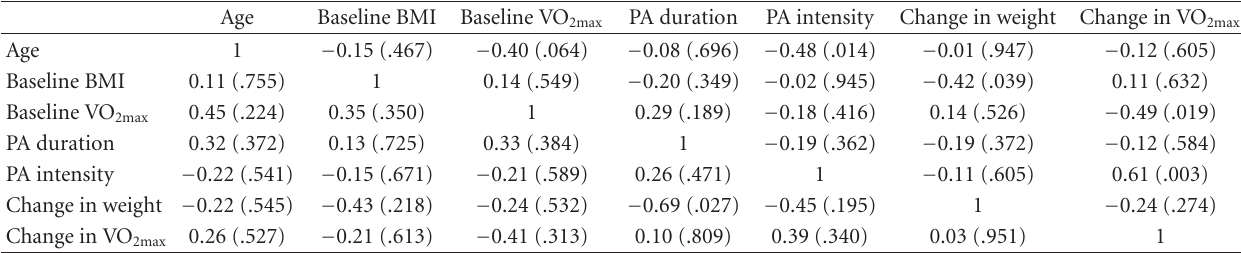
Table 3: Correlation matrix between independent and dependent variables in the regression analyses for men ( n = 8–10) in the lower left corner and women ( n = 22–25) in the upper right corner (Pearson r ( P value)). BMI: body mass index; VO 2max : estimated maximal oxygen